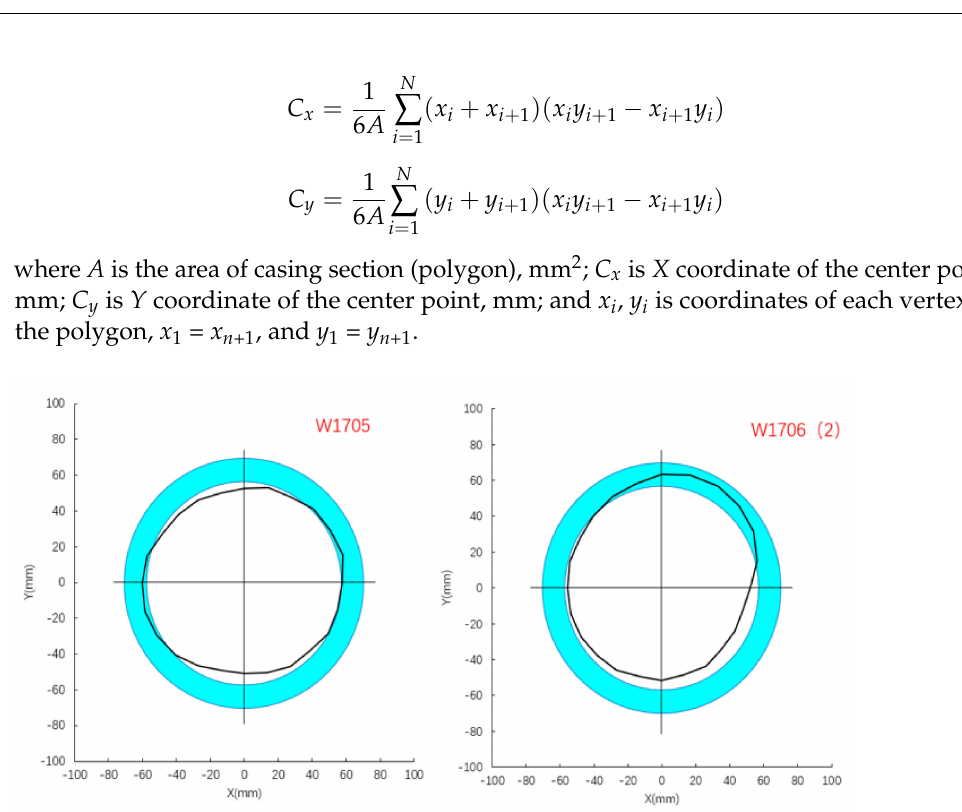
Figure 6. Sub-divisions of type 2 (ellipse casing deformation) sections from Weiyuan oil field: W1705 symmetric ellipse section ( left ) and W1706(2) eccentric ellipse section ( right ). From the fault distribution map (Figure 7), it can be seen that well W1706(2) and well W18-1 lie within the vicinity of the fault. The casing deformation position of these two wells is precisely at the points where the fault crosses the well trajectory, which indicates that the fault slip may be the main cause of type 1 and type 2-2 deformations.